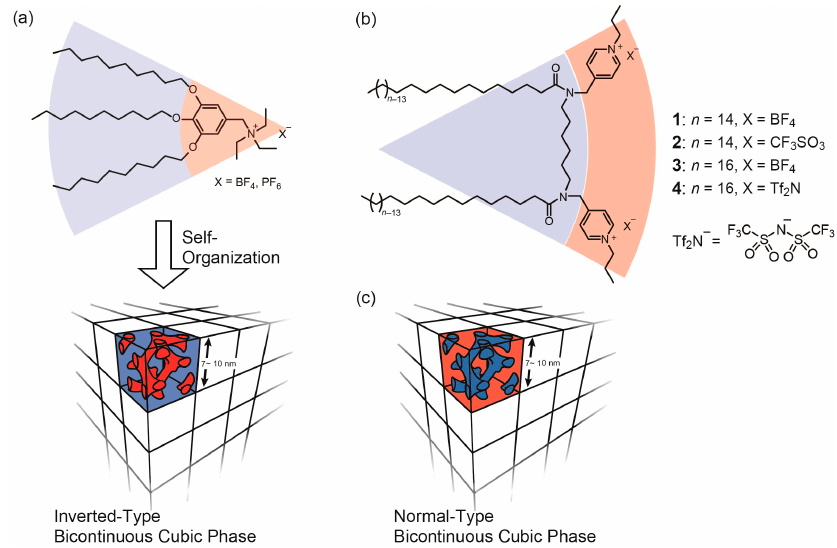
Figure 1. ( a ) A series of wedge-shaped ammonium salts forming inverted-type bicontinuous cubic (Cub bi ) phases [13]. ( b ) Molecular structure of gemini-type amphiphile 1–4. ( c ) A schematic illustration of a normal-type Cub bi phase.